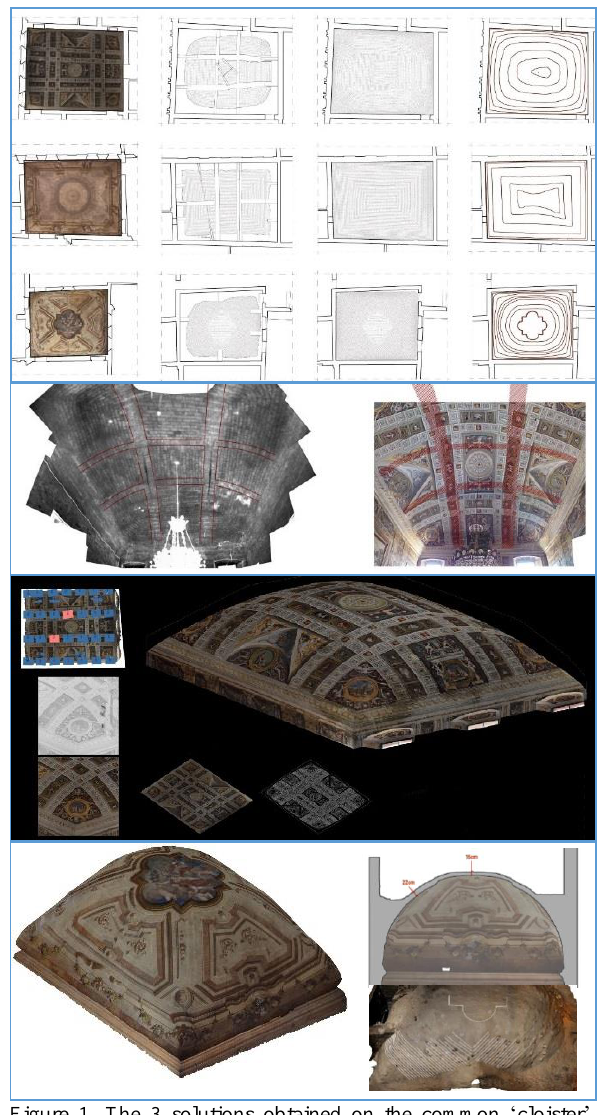
Figure 1. The 3 solutions obtained on the common ‘cloister’ typology (upper), and some details of the 2 deviations: the Manfredini Hall, Closter - to –Trompe solution (centre), and the Stair Hall, Cloister-to-Dome-to Trompe corners (below); Magio Grasselli